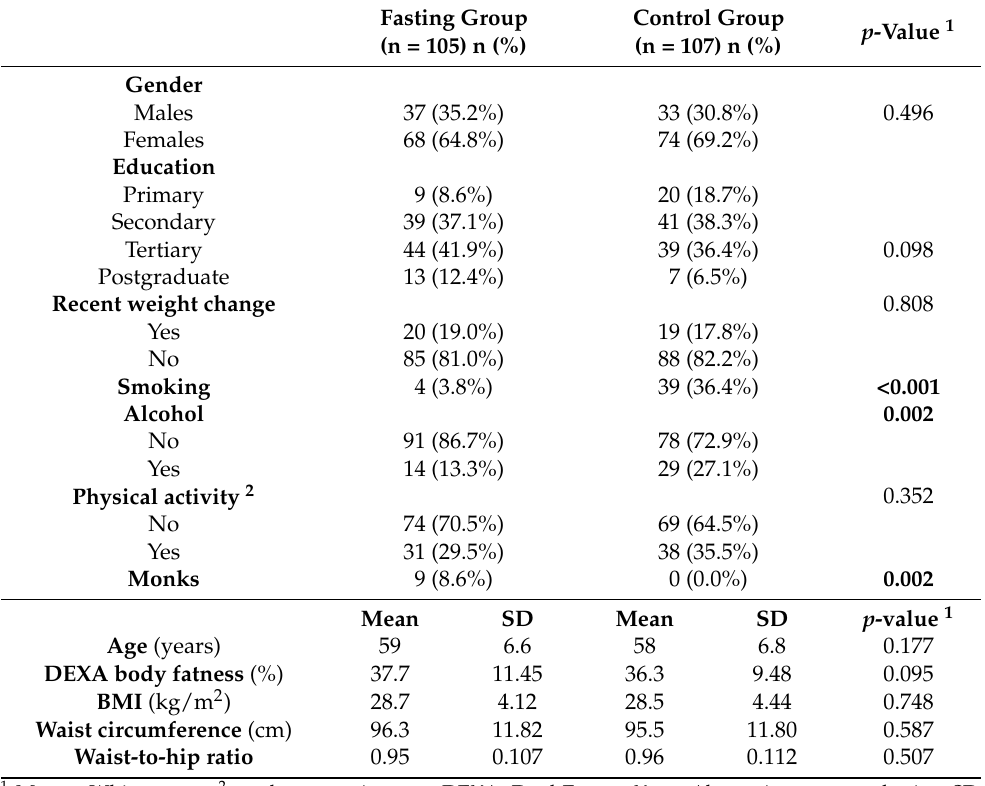
Table 1. Demographic and anthropometric characteristics of fasting and non-fasting individuals.